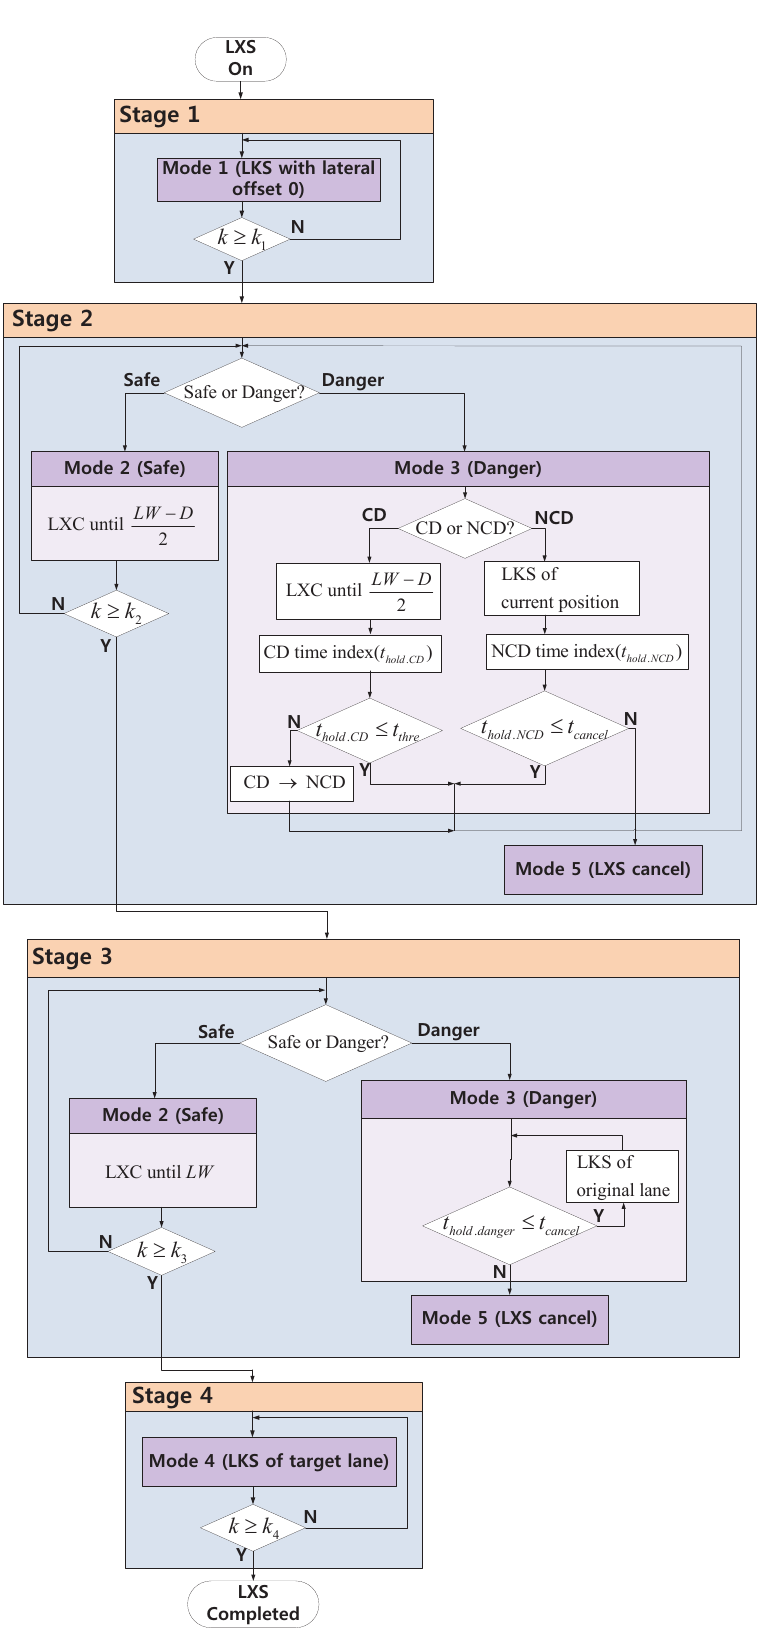
Figure 5. Flow chart for risk assessment according to the strategy of